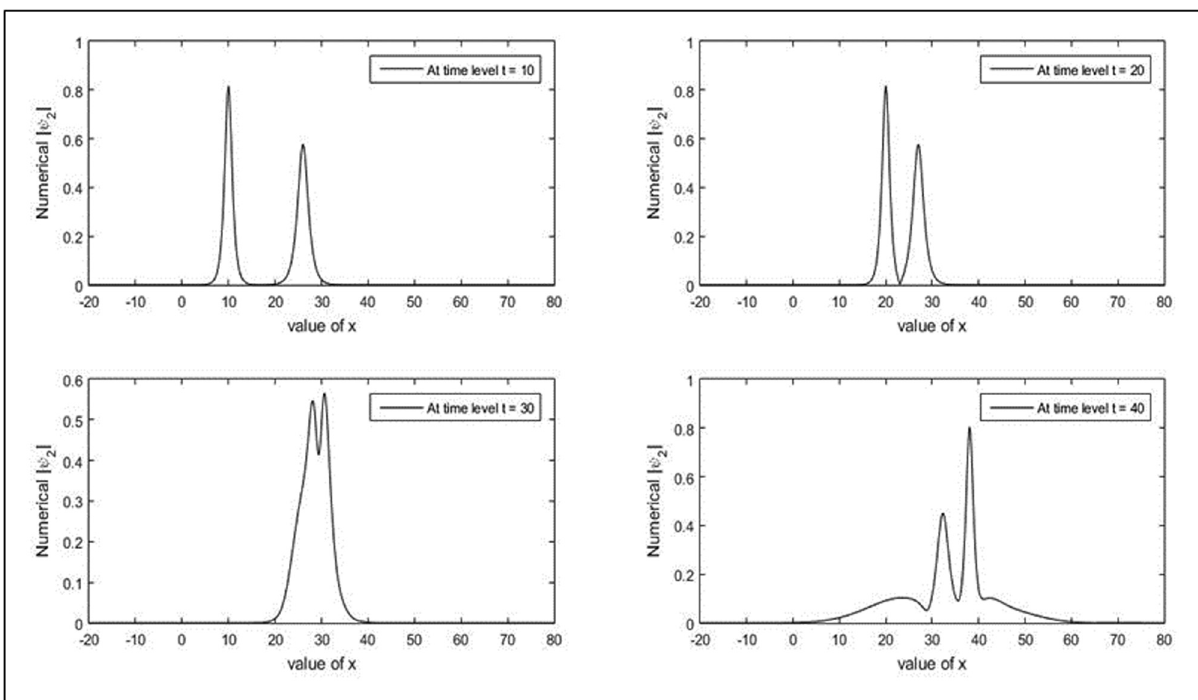
Figure 6: Interaction of two solitons for second - wave amplitude for = N 501 ,